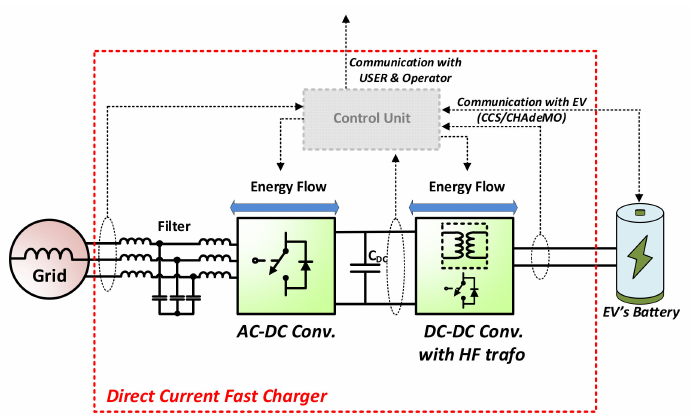
Figure 1. Block scheme of the analyzed Direct Current Fast